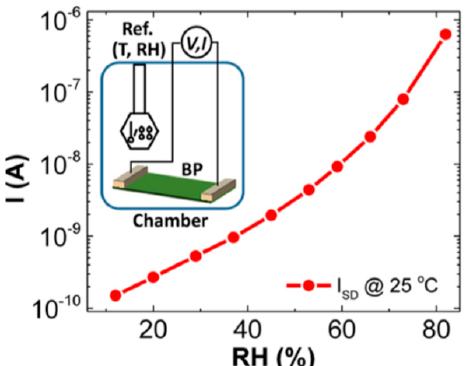
Figure 9. The current of a typical BP sensor measured at fixed voltage versus RH at 25 °C. The inset shows the scheme of the custom-made chamber that is used for the experiment. Reproduced with permission from Ref. [95]. Copyright ACS, 2015.